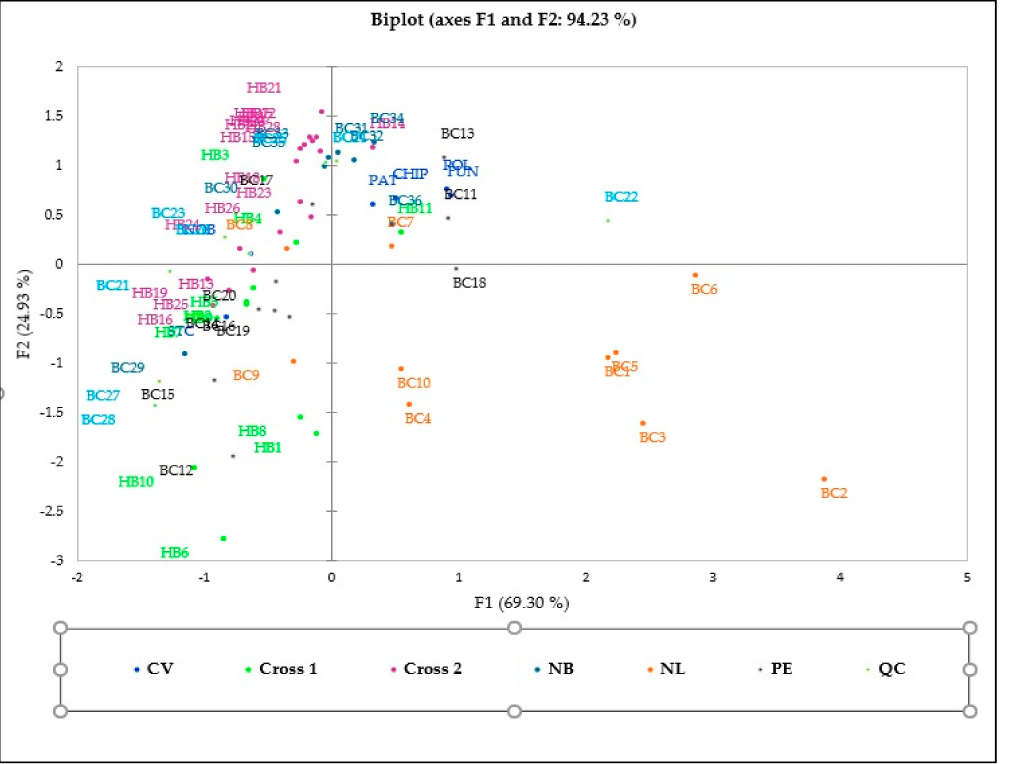
Figure 3. PCA biplot based on biochemical characteristics of 70 genotypes and correlation among quantitative